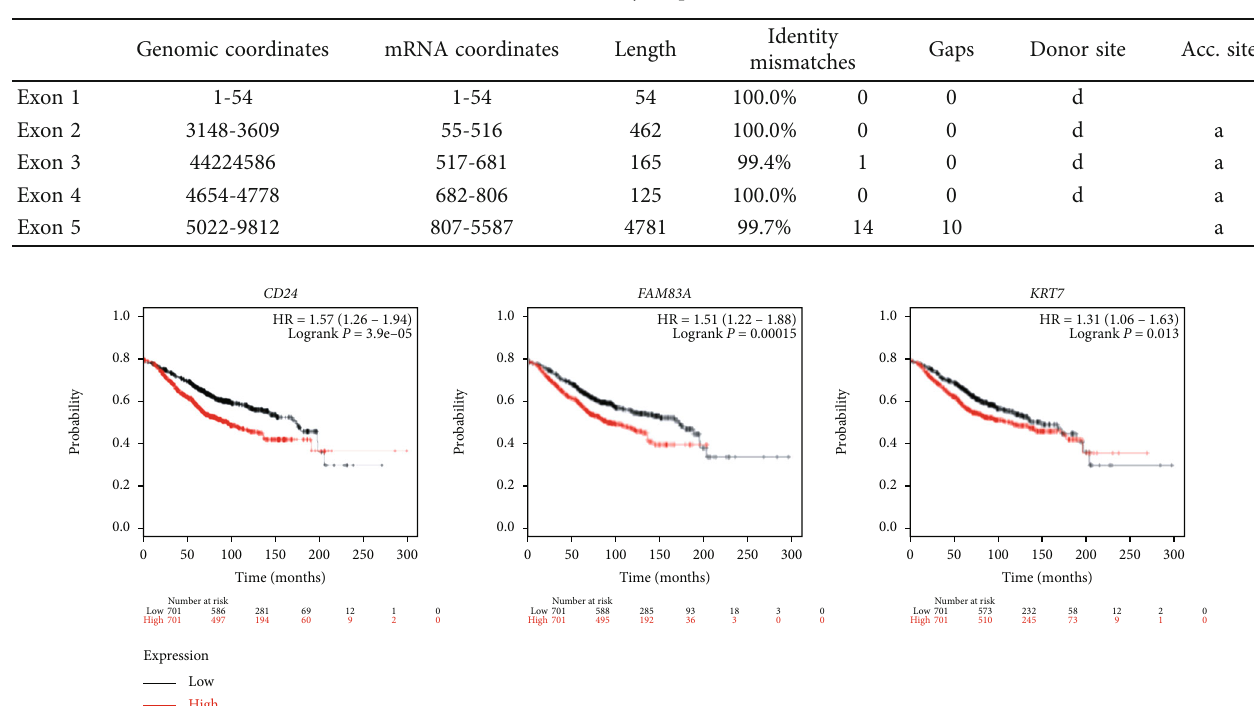
Table 2: Exon and intron layout prediction for FAM83H.